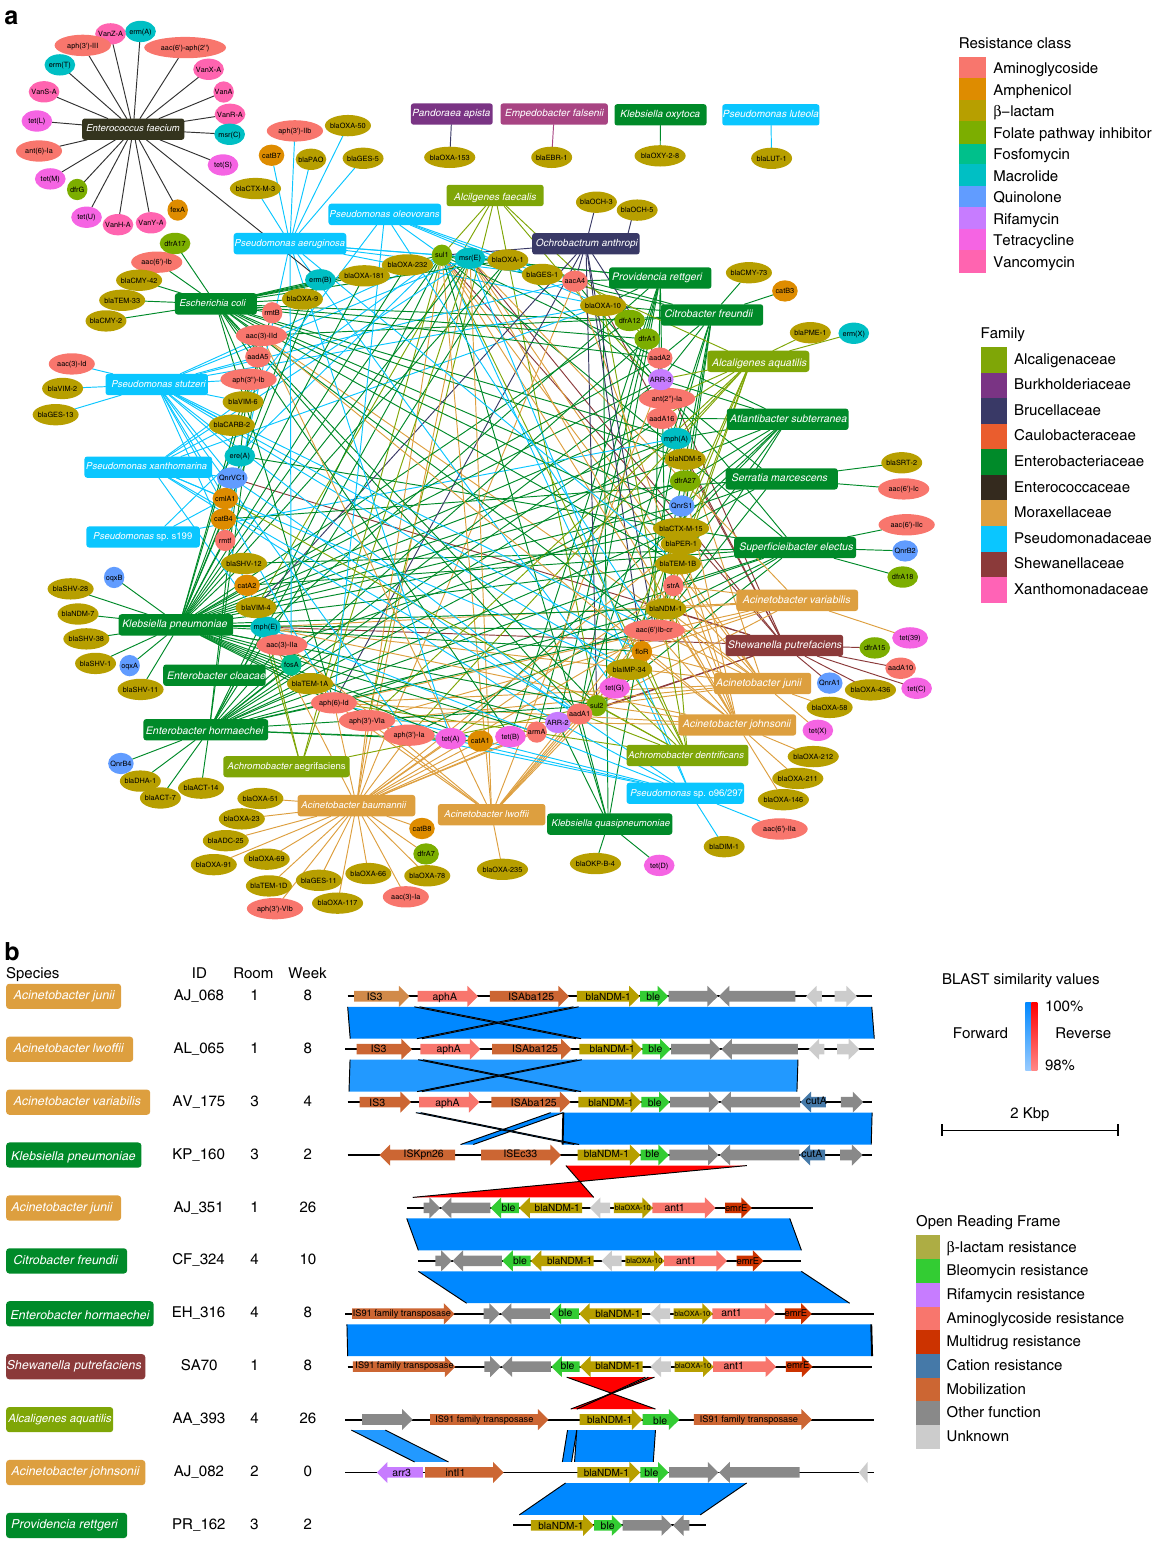
Fig. 8 Shared antibiotic resistance genes across diverse taxonomic groups. a Species and resistance gene network diagram. Species are represented as rectangles colored by family. Resistance genes are represented by ovals colored by resistance gene class. Lines colored by species family are drawn from each species to all the resistance genes annotated by Res fi nder in that species isolates. b Annotated bla NDM-1 contigs in 11 isolates. Protein annotations colored by putative function are shown as arrows for each isolate ’ s bla NDM-1 contig. BLAST similarity values greater than 98% between contigs are shown in blue if they are oriented in the forward direction and red if they are oriented in the reverse direction. Species names are shown on the left in rectangular boxes colored by family and isolate ID, room, and week are also labeled. Source data for both panels are provided in the source data fi